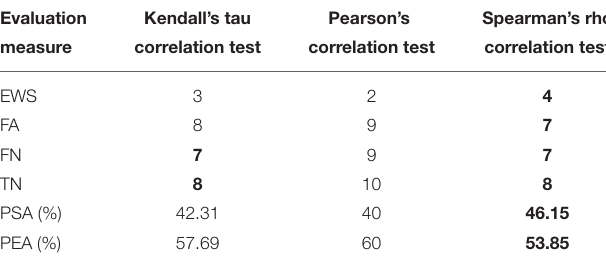
TABLE 2 | A summary for all obtained results.